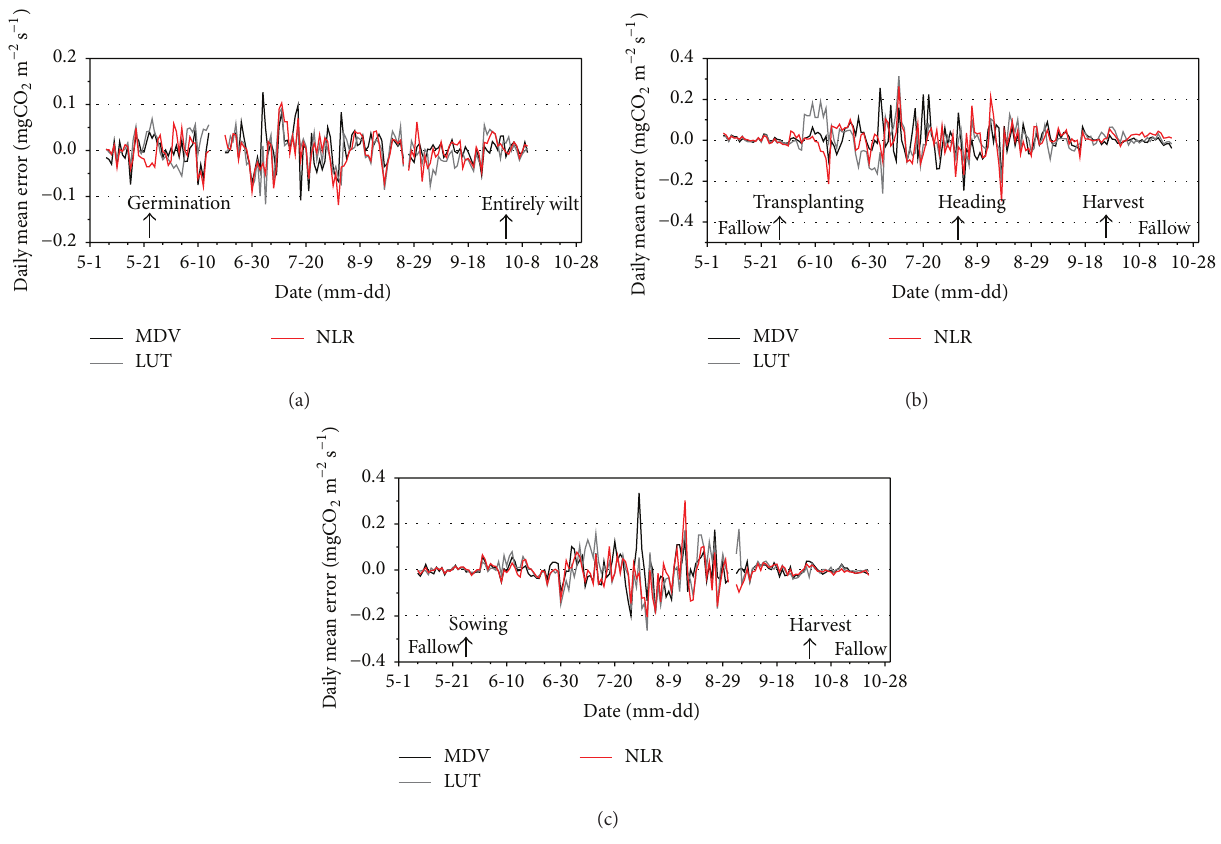
Figure 4: Seasonal variations of daily mean bias error (MBE) with different methods at (a) marsh, (b) rice, and (c) soybean sites.